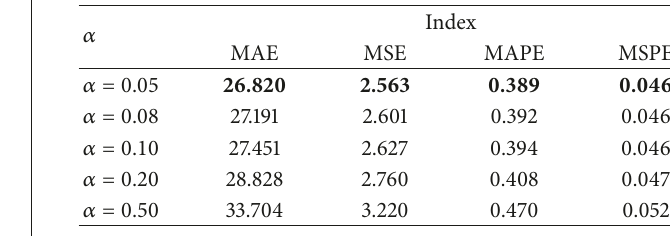
Table 1: Evaluation index of first-order difference exponential smoothing